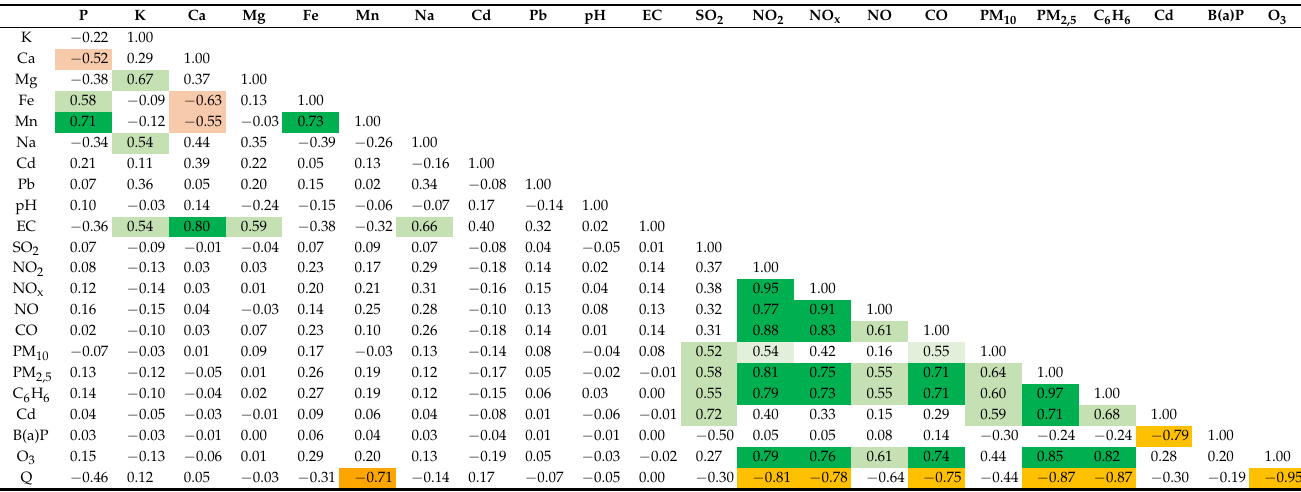
Colors represent the following: light orange—high negative correlation, orange—very high negative correlation, light greed—high positive correlation, green—very high positive correlation. The performed CCA analysis confirms the relationship between the studied trees’ health status in city parks and the analyzed chemical parameters in soil and air. In